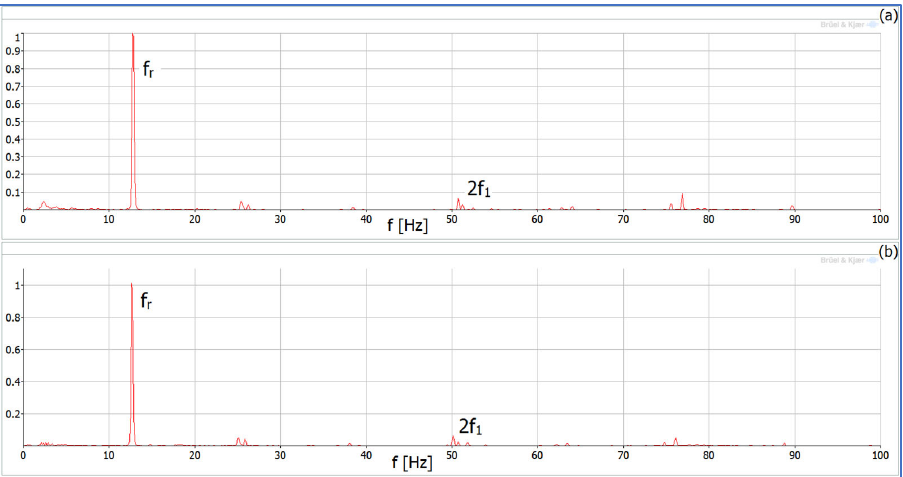
Figure 18. Vibration spectral characteristics for a rotational speed of 750 rpm and under load, where ( a ) characteristic—1h supply, ( b ) characteristic—1h and 3h supply.